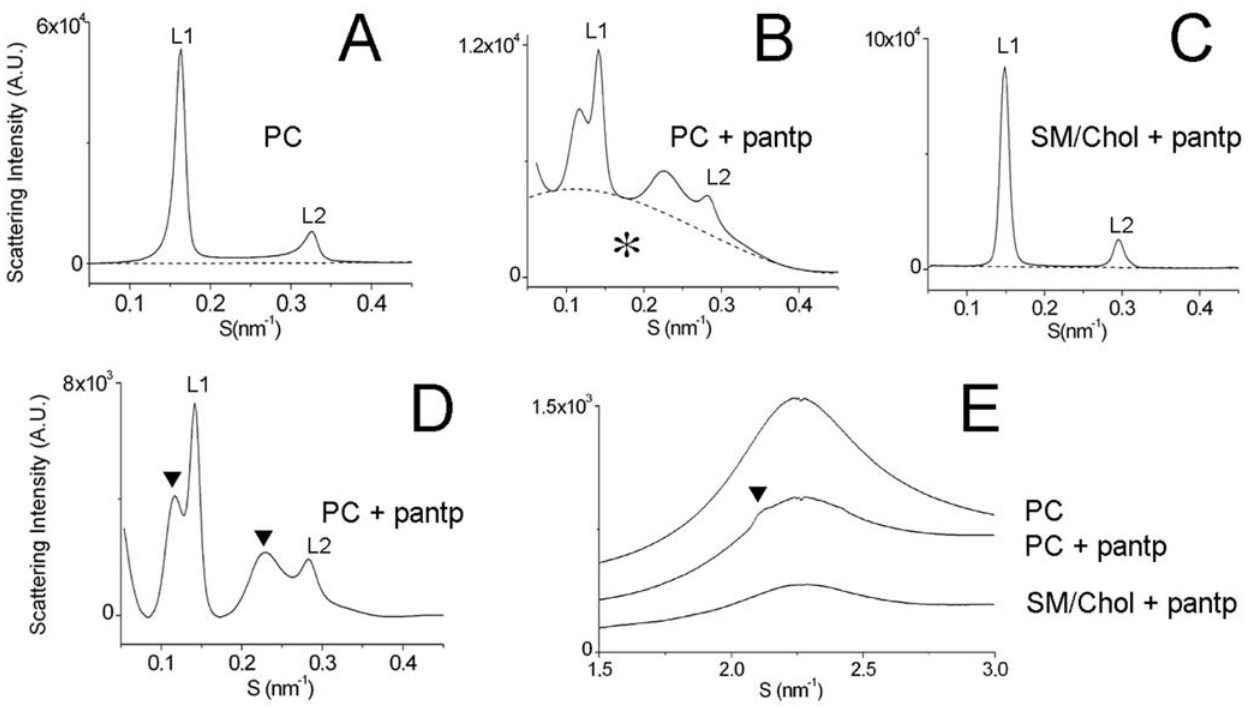
Figure 6. Effects of Penetratin observed by small angle and wide angle X-ray diffraction. A to D small angle X-ray diffraction. Diffractograms are not corrected for the base line; (A) PC membranes, (B) PC membranes in the presence of Penetratin showing a ‘‘distorted baseline’’ (star) corresponding to the form factor contribution. The broad signal was tentatively related to the formation of small vesicles, (C) SM/Chol (1/1) membranes in the presence of Penetratin. (D) Diffractogram is subtracted for the distorted baseline. PC membranes in the presence of Penetratin show first (L1) and second (L2) order Bragg peaks of a lamellar phase (d-spacing in the ratio 1:1/2). The peaks as compared to (A) in the absence of peptide are shifted to the left indicating an increase in the repeat distance from 6.01 to 7.05 nm. In addition, Penetratin induces the splitting of peaks and the separation of a lamellar phase with considerably larger repeat distance (arrowheads). (E) Effects of Penetratin as observed by the wide angle X-ray diffraction. Peaks of PC MLV membranes are shown in the absence (top) and in the presence of Penetratin (middle). Peak of SM/Chol membranes is also shown in the presence of Penetratin (bottom). The arrowhead indicates the unresolved contribution assumed to correspond to the increased inter-acyl chains spacing. All experiments presented were done at 25 u